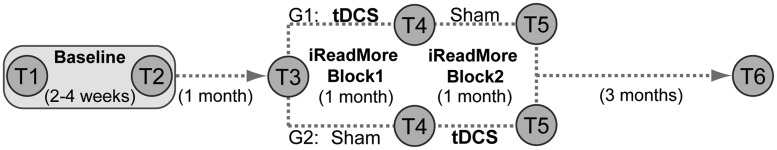
Study design. G1 = Group1: received tDCS in Block 1 and sham in Block 2. G2 = Group2: received sham in Block 1 and tDCS in Block 2.